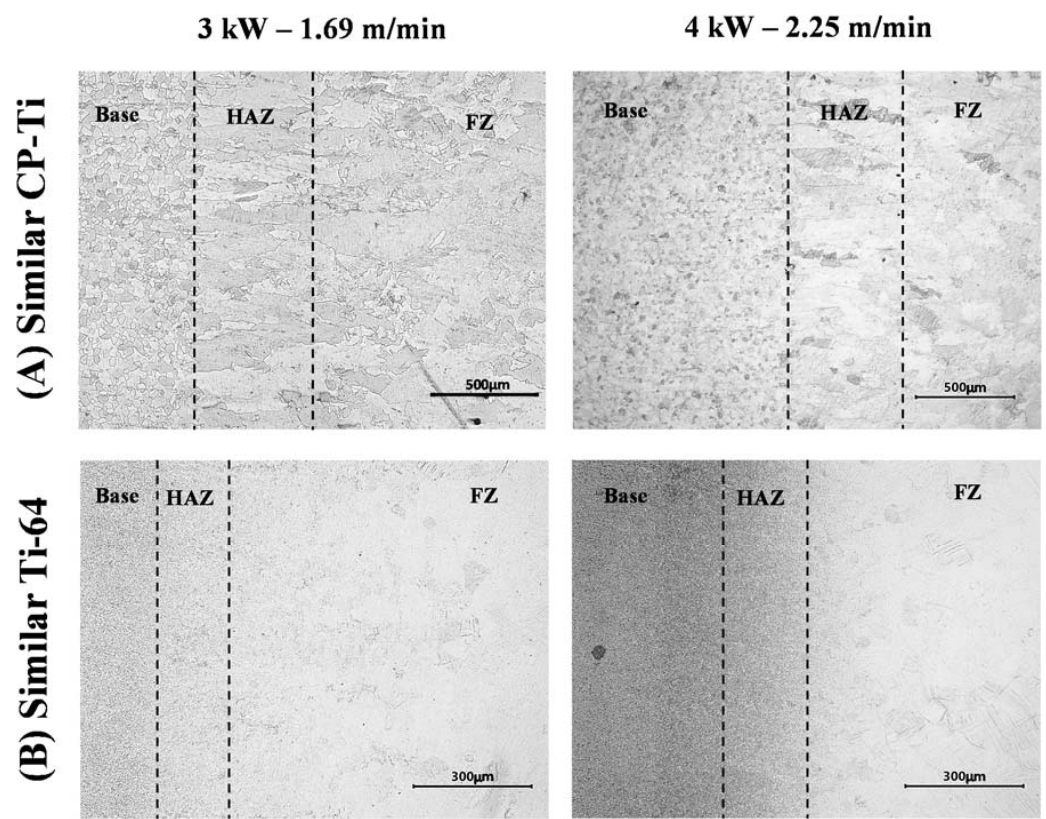
Figure 3. Heat ‐ affected zone (HAZ) and fusion zone (FZ) for similar ( A ) CP ‐ Ti and ( B ) Ti ‐ 64 joints Figure 3. Heat-a ff ected zone (HAZ) and fusion zone (FZ) for similar ( A ) CP-Ti and ( B ) Ti-64 joints welded by 3 and 4 kW laser power. welded by 3 and 4 kW laser